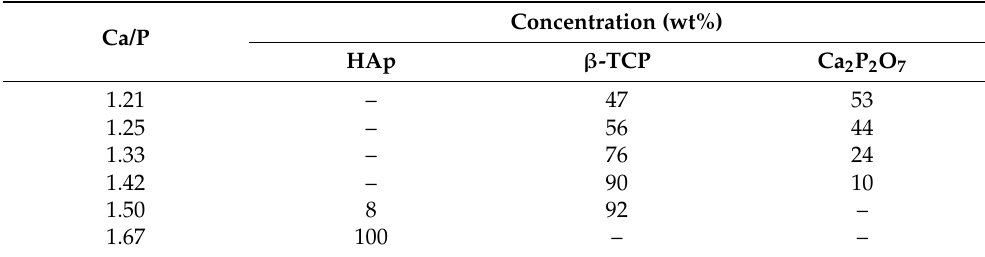
Table 5. Composition of the samples after STA.